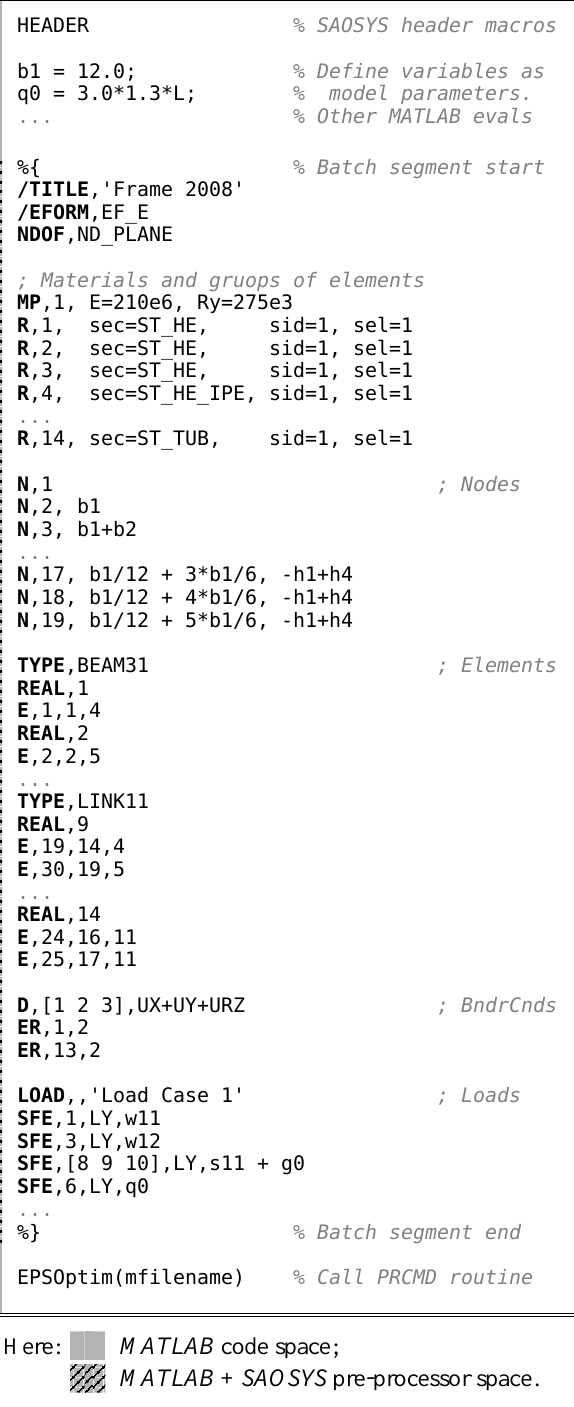
Fig. 20. Sample initial data and a batch file